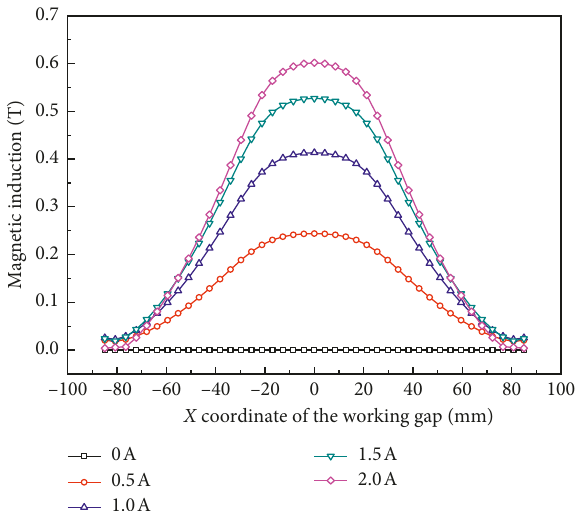
Figure 9: Magnetic induction curve in the working channel of the MRG cylinder.